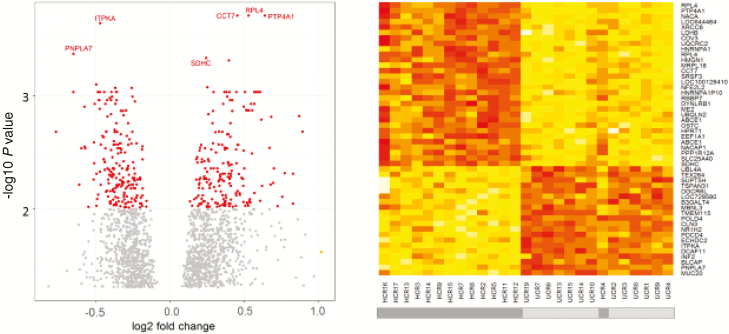
Differential gene analysis of noninflamed rectal biopsies from UC patients and HCs. A, Volcano plot of all HC vs UC rectal genes. Genes colored red are significantly different, with an adjusted P < 0.01. B, Heatmap of the 50 most differentially expressed genes between UCs and HCs (according to adj P value), where the color scale for relative expression level is from low (red) to high (white).